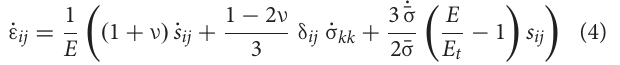
FIGURE 2 | Unloading in the flow theory of plasticity.